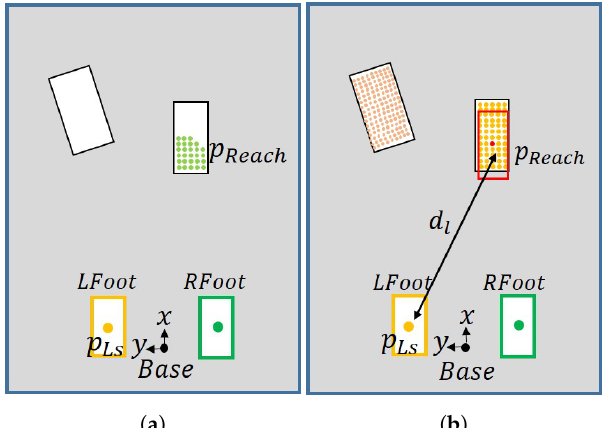
Figure 10. Algorithm for determining foot position using distance and overlapping area. ( a ) Points within the maximum distance; ( b ) Rectangle the size of foot around the point.